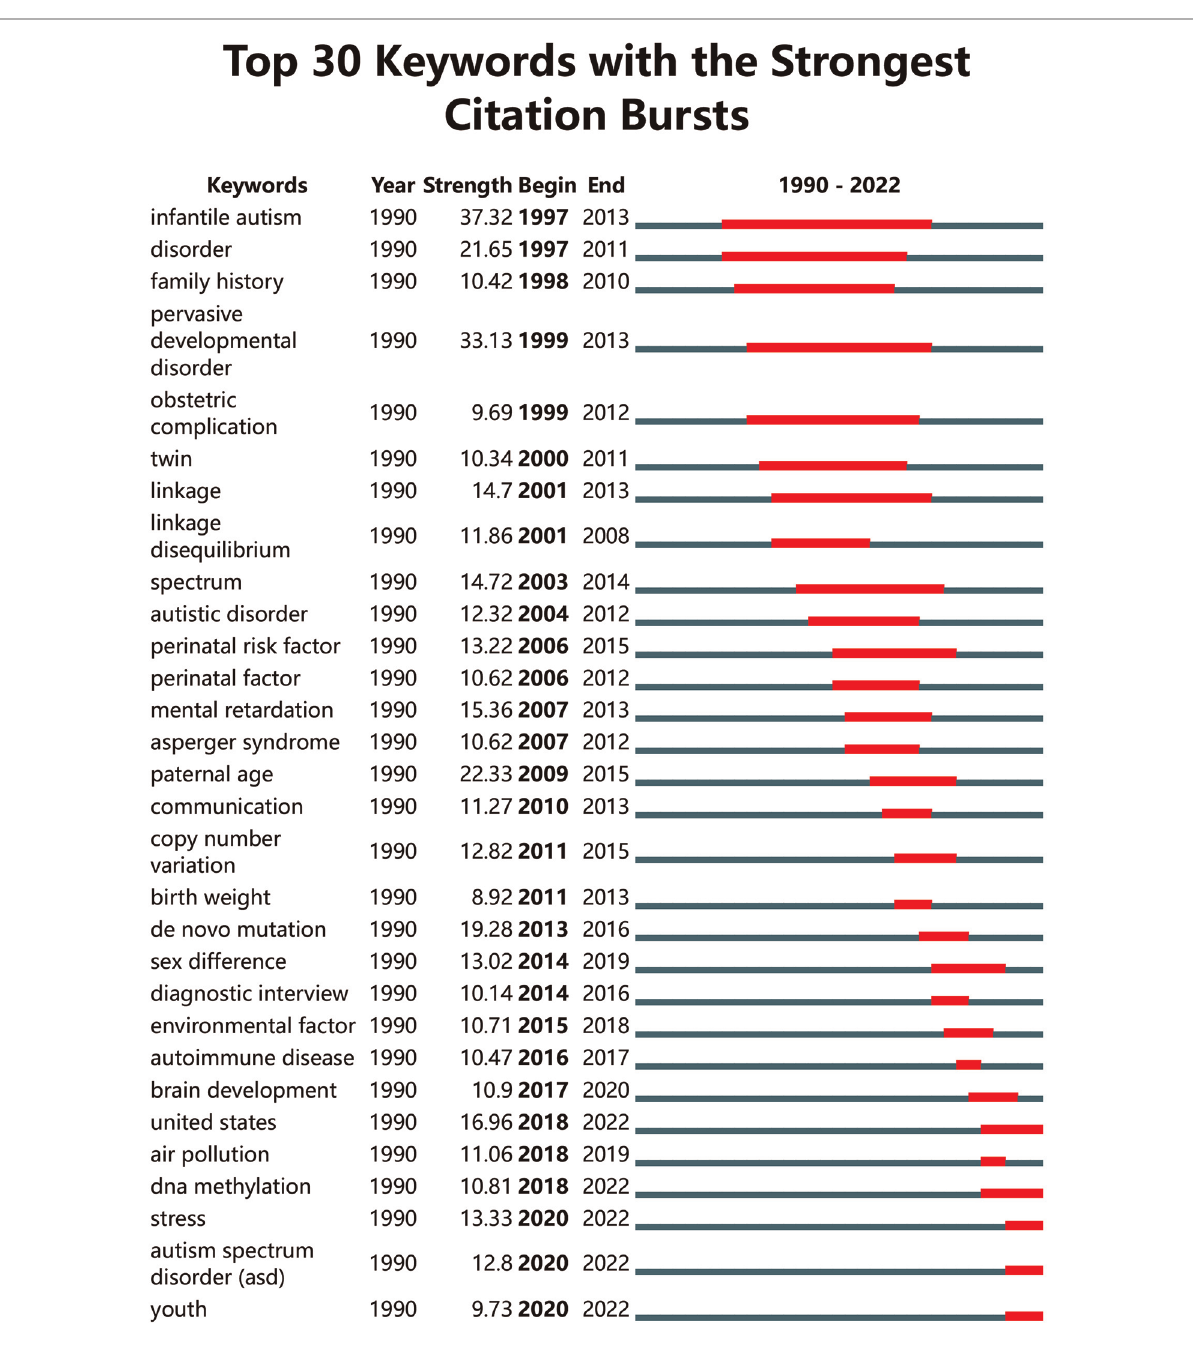
FIGURE 7 The top 30 keywords with the strongest citation bursts related to risk factors on ASD since